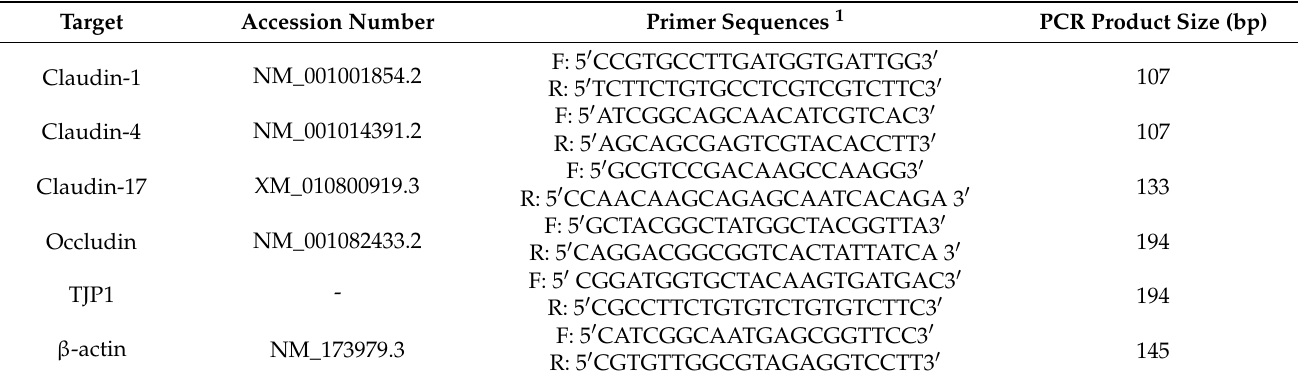
Table 2. Sequences of primer used to analyze gene expression in rumen epithelial tissue by quantitative